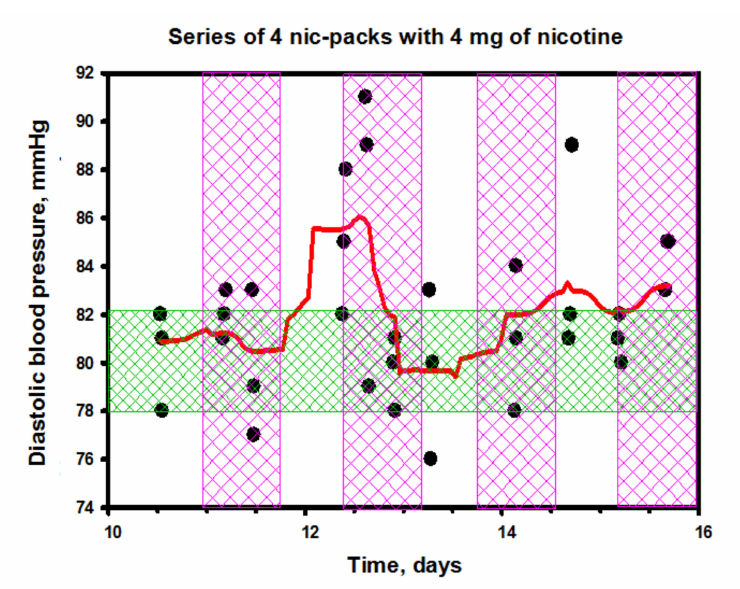
Figure 18. Changes in diastolic blood pressure (DBP) during the period of nic-pack